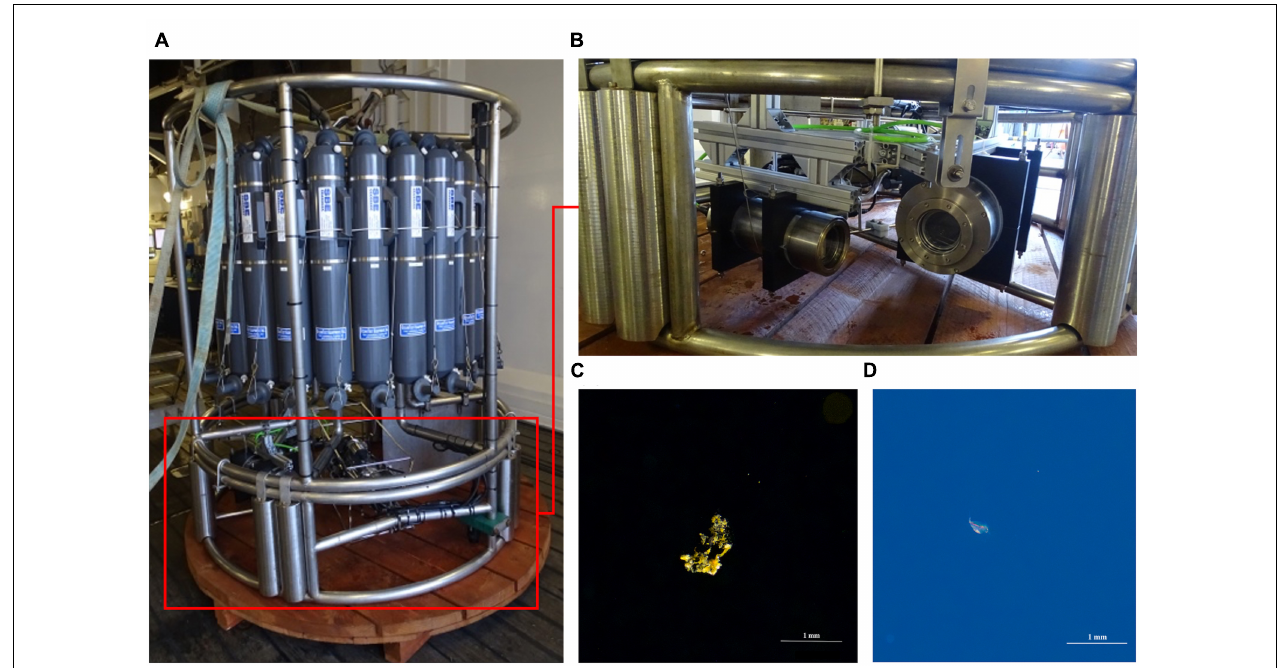
FIGURE 3 | (A) CTD-Rosette in the hangar of RV Sonne . (B) The PartiCam installed in the lower section of the CTD-Rosette next to the CTD. Examples of particles captured by the PartiCam system: marine snow (C) and a swimming copepod (D)